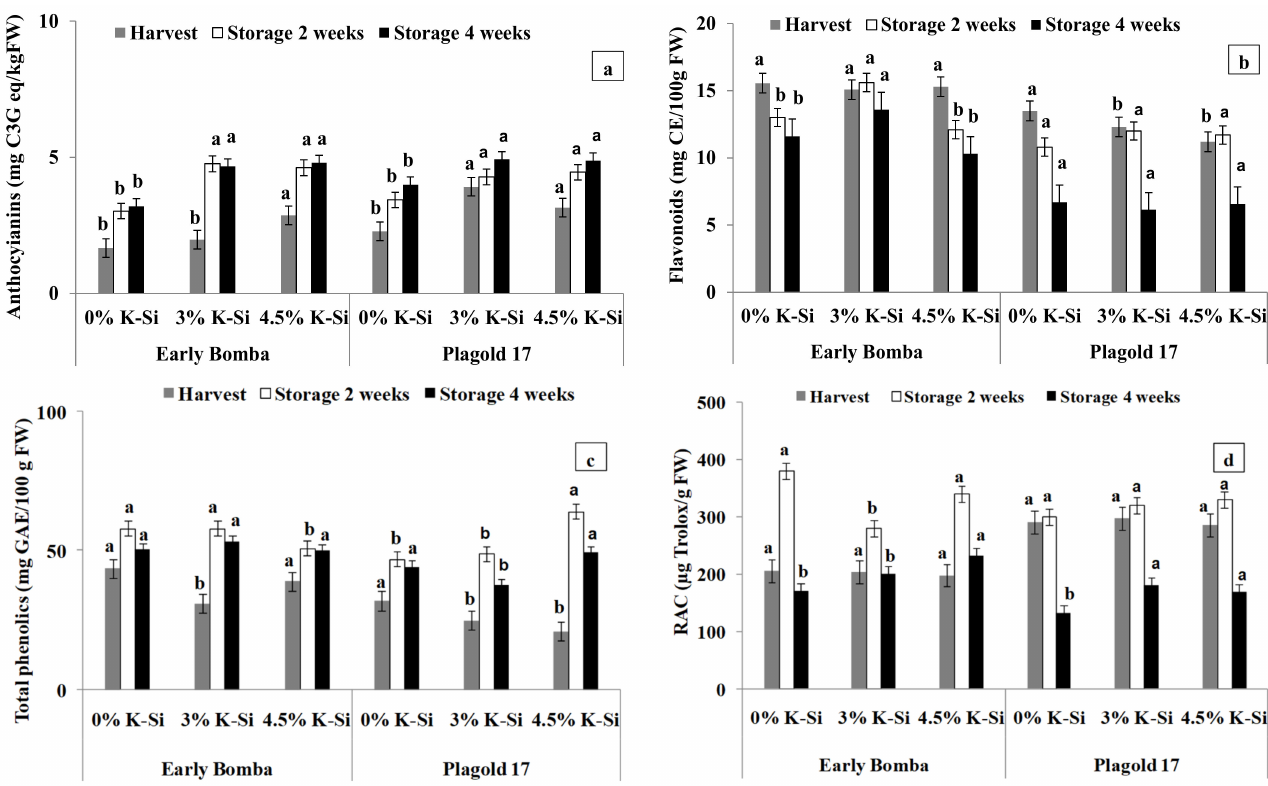
Figure 2. Influence of potassium silicon spray and storage period on contents of anthocyanins ( a ), flavonoids ( b ), total phenolics ( c ), and relative antioxidant capacity (RAC) ( d ), among two peach cultivars at harvest and after 2- and 4-week cold storage periods during the growing seasons (2021–2022). Abbreviations: Values are the means ( n = 3) ± standard error. Different letters a, b, indicate difference ( p < 0.05) among K-Si treatments in each cultivar according to Scheffe’s multiple range test.